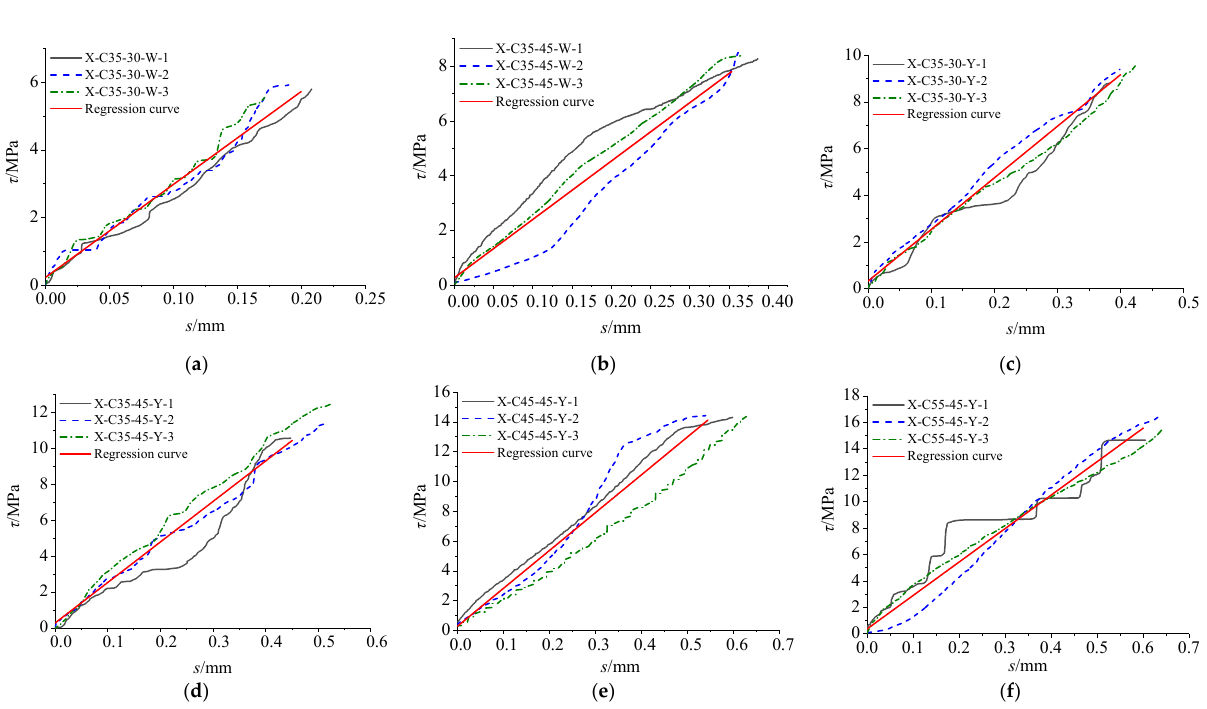
Figure 9. Bond stress–slip curves of slant shear specimens: ( a ) X-C35-30-W; ( b ) X-C35-45-W; ( c ) X-C35-30-Y; ( d ) X-C35-45-Y; ( e ) X-C45-45-Y; ( f ) X-C55-45-Y.